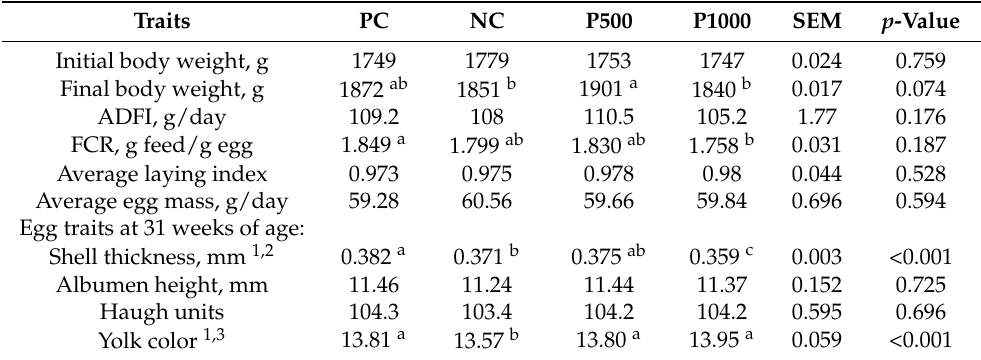
Table 4. Effect of dietary phytase inclusion on performance and egg production traits of laying hens from 22 to 31 weeks of age. Traits PC NC P500 P1000 SEM p -Value Initial body weight, g 1749 1779 1753 1747 Final body weight, g 1872 ab 1851 b 1901 a